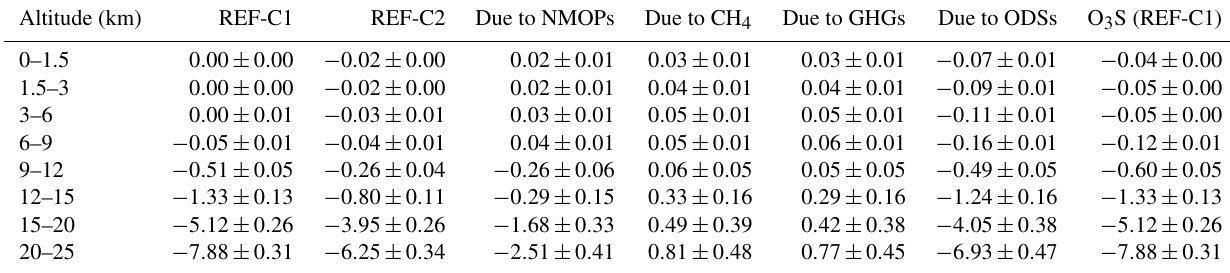
Table 6. Simulated trends in O 3 and O 3 S anomalies ( ± 1 standard deviation) at Lauder, and attributions of modelled trends due to changes in non-methane O 3 precursors, CH 4 , GHGs, and ODSs over the period of 1960–2010. Units are ppbvyear − 1 . Altitude (km) REF-C1 REF-C2 Due to NMOPs Due to CH 4 Due to GHGs Due to ODSs O 3 S (REF-C1)